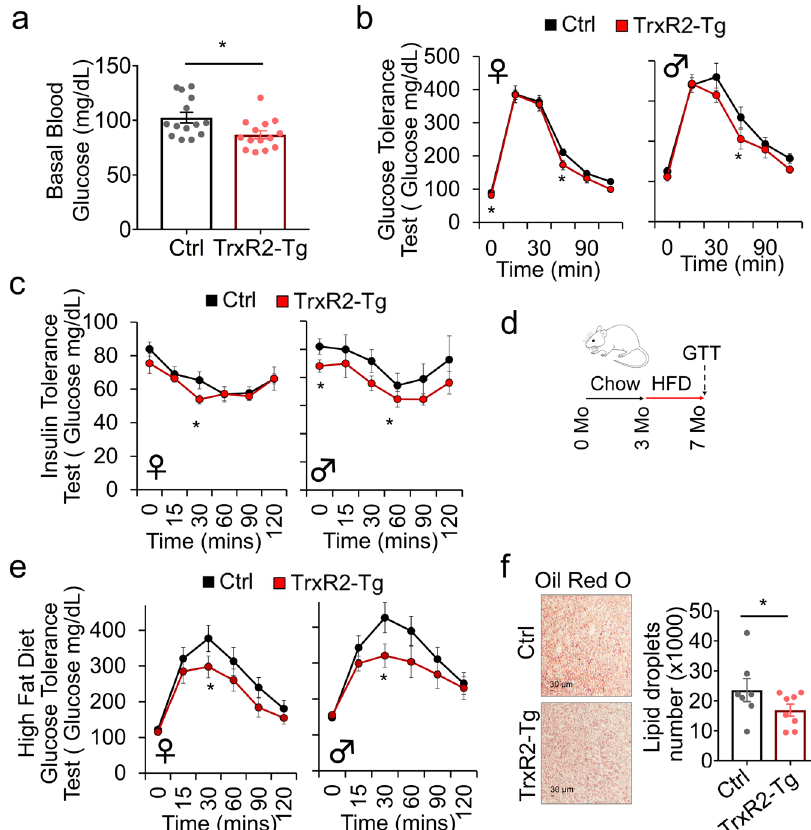
Fig. 2 Glucose metabolism and tolerance is improved in TrxR2-Tg mice maintained on standard chow and high-fat diet. a TrxR2-Tg mice have lower basal blood glucose, 7 months old mice (ANOVA with Tukey ’ s test, n = 7 – 9). b Chow-fed 8-month-old TrxR2-TG mice show improved glucose tolerance compared to littermate controls ( n = 7 – 9) separate tests were done for female and male groups. c Chow-fed 8-month-old TrxR2-TG mice have higher insulin sensitivity than littermate controls separate tests were done for female and male groups ( n = 8 – 9). d Schematic of high-fat diet feeding regime used in panels e , f . e High-fat diet-fed 8 months old TrxR2-Tg mice show improved glucose tolerance compared to littermate controls separate tests were done for female and male groups ( n = 8 – 10). f High-fat diet-fed 8 months old, males and females TrxR2-Tg mice have decreased liver fat compared to littermate controls. Oil Red O stain of liver slices, n = 8. Values are Mean± SEM. * p < 0.05, ** p <